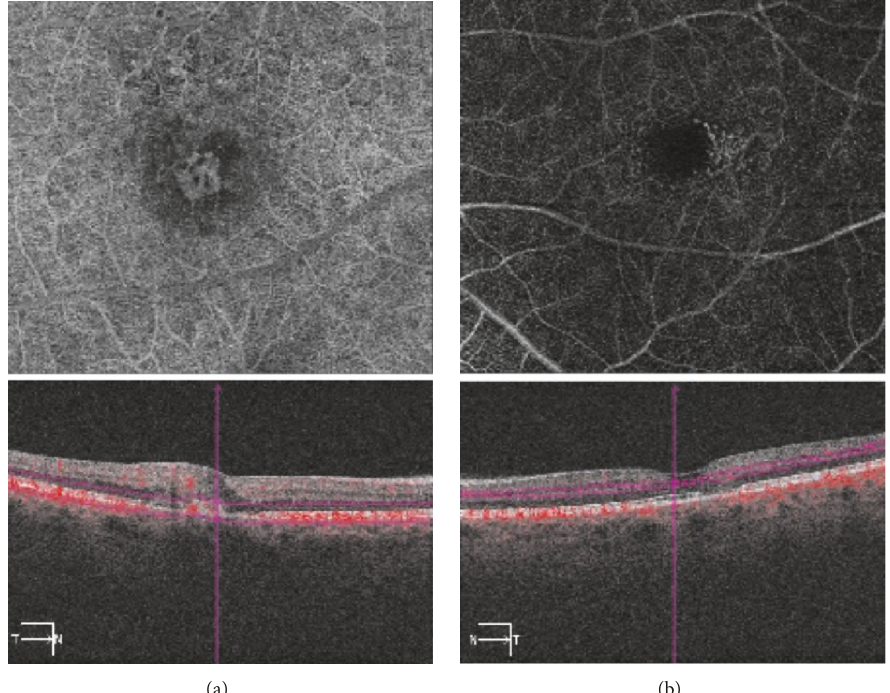
Figure 3: (a) OCTA OD at the level of the outer retina and choriocapillaris shows subretinal neovascularization. (b) OCTA OS demonstrates microvascular abnormalities in the deep capillary plexus of the retina most prominent